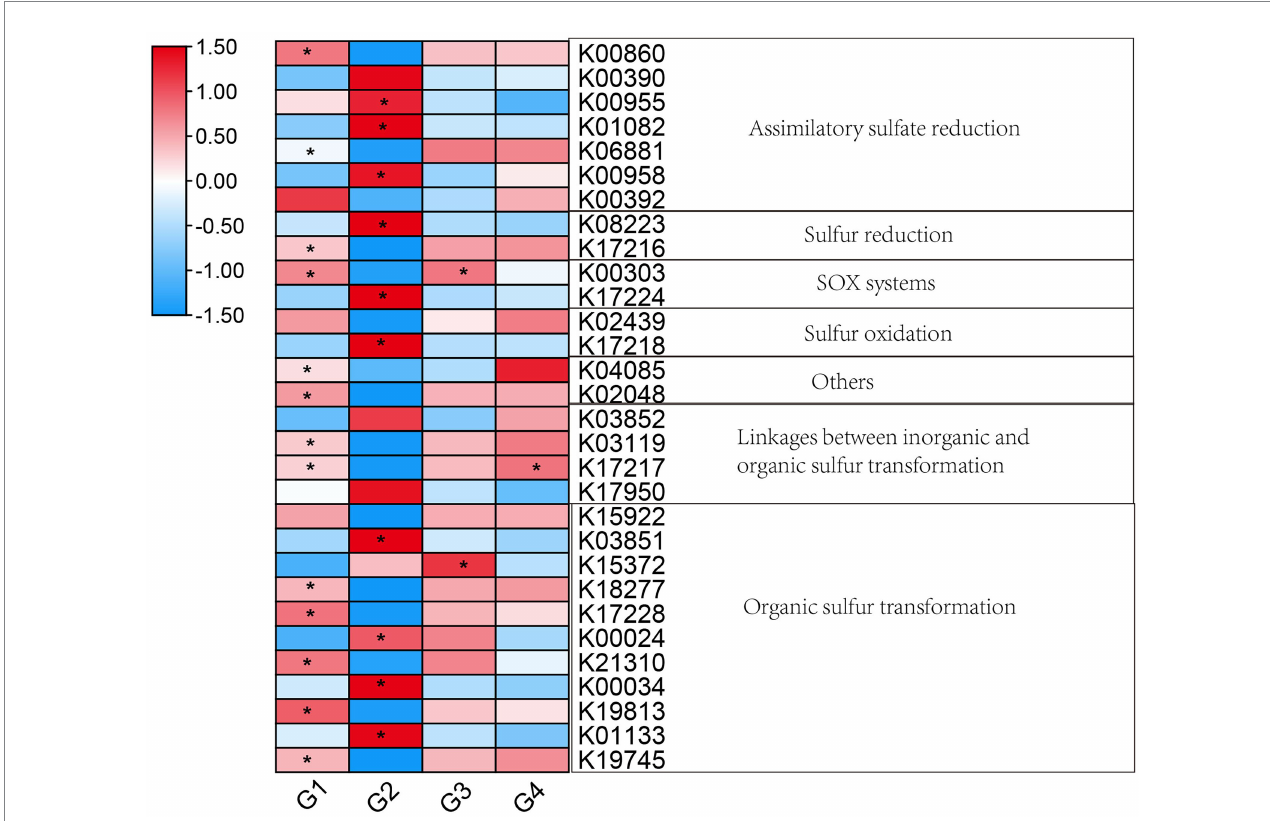
FIGURE 8 Heatmap of genes related to the sulfur cycle. Colors from blue to red indicate the log 2 value (absolute abundance). * p < 0.05, independent-samples t -test was conducted for comparisons between G1 and G2, G3 and G4. G1, 101-14 treated with NaCl; G2, 101-14 treated with ddH 2 O; G3, 5BB treated with NaCl; G4, 5BB treated with ddH 2